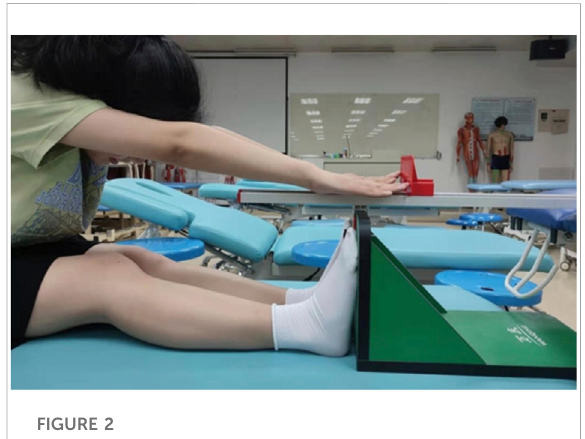
FIGURE 2 Measurement of the SR test.